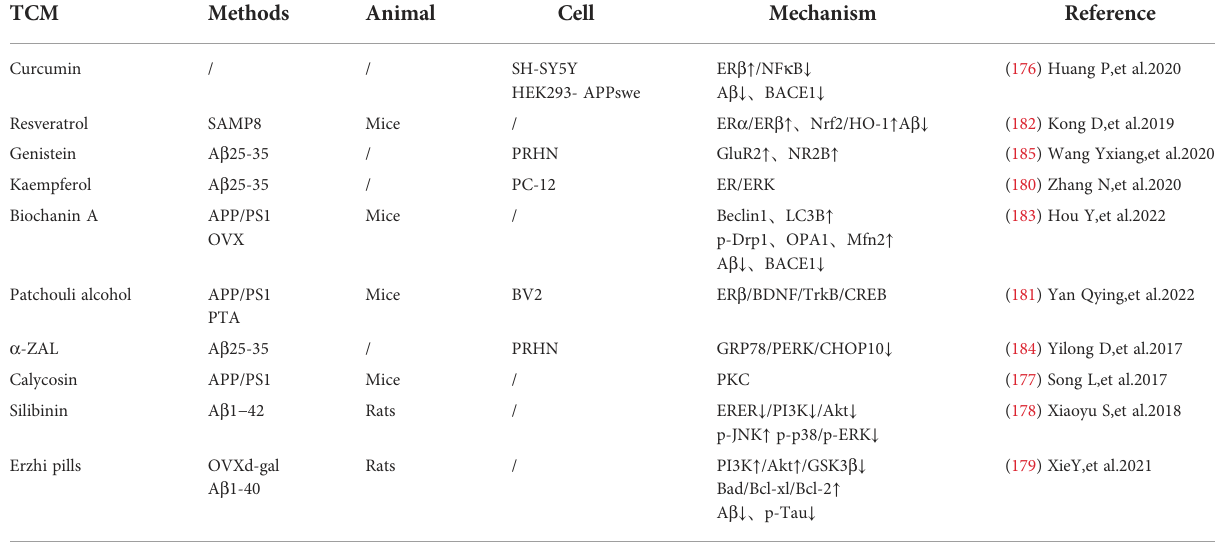
TABLE 5 Mechanisms associated with phytoestrogen treatment with